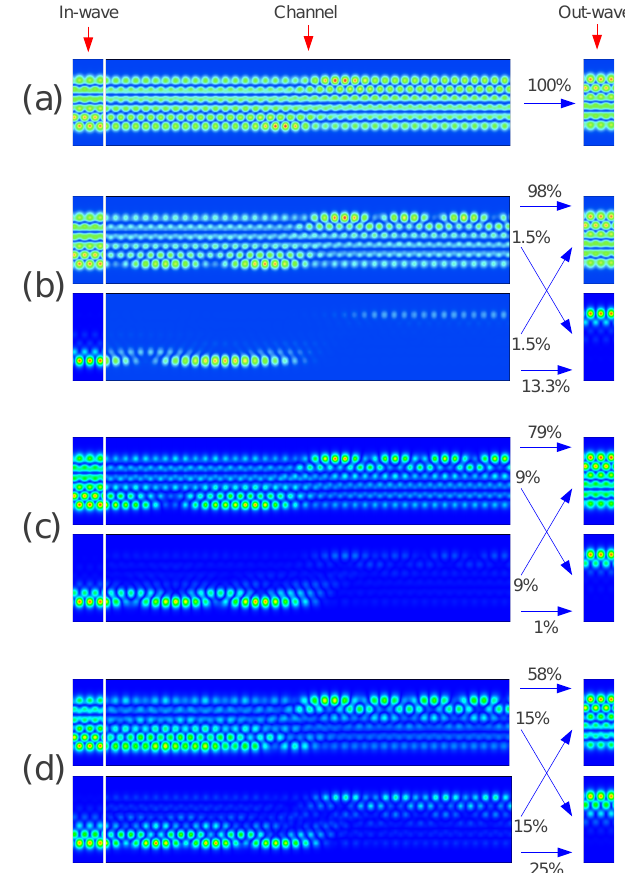
Figure 6. Scattering of the Bloch states from the source lead to the drain through the heterojunction in the zGNR-6 for ( a ) E = − 400 meV (in Region (I)); ( b ) E = − 349 meV (left-side peak in Region (II)); ( c ) E = − 320 meV (middle dip in Region (II)); ( d ) E = − 275 meV (right-side peak in Region (II)). The transmissions between the different Bloch states are indicated by the percentages close to the blue